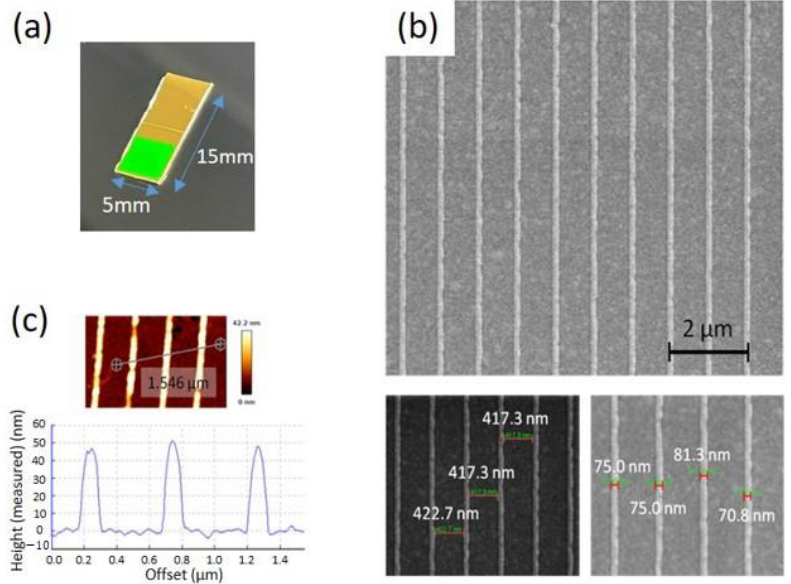
Figure 1. Surface characterization of a COP based capped gold nanoslit arrays: ( a ) the photographic image of EC-SPR sensor; ( b ) SEM images and nanoslit width measurement; ( c ) surface roughness and nanoslit height measurement using atomic force